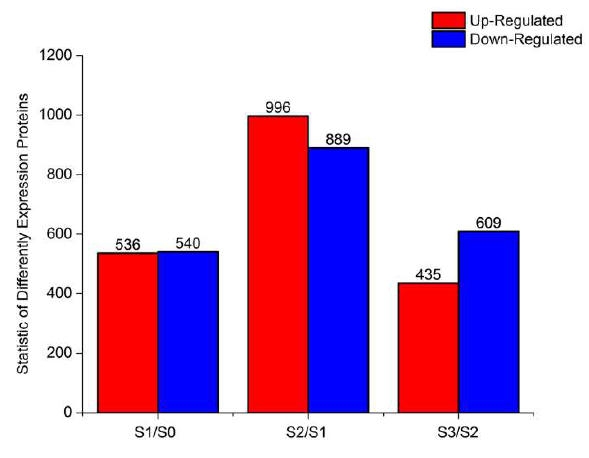
Figure 5. The statistics of DEPs